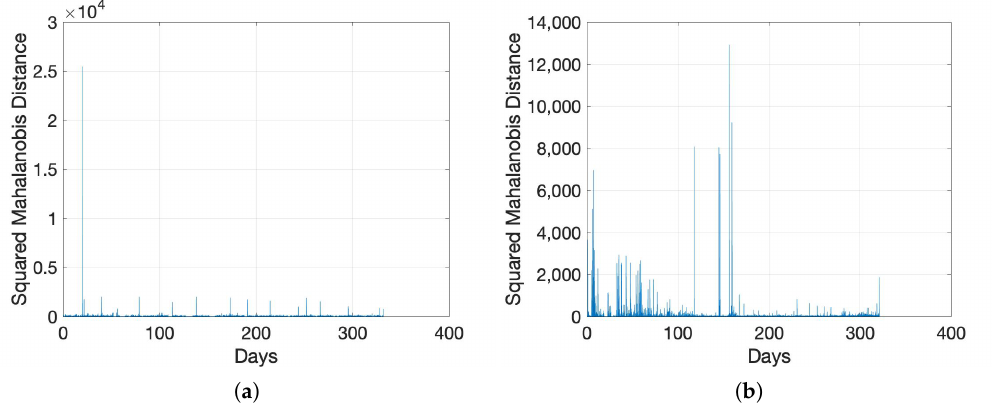
Figure 2. SMD for the in-field collected data using ARIMA ( 2,1,1 ) . ( a ) Data Set Exp MV ; ( b ) Data Set Exp LV .